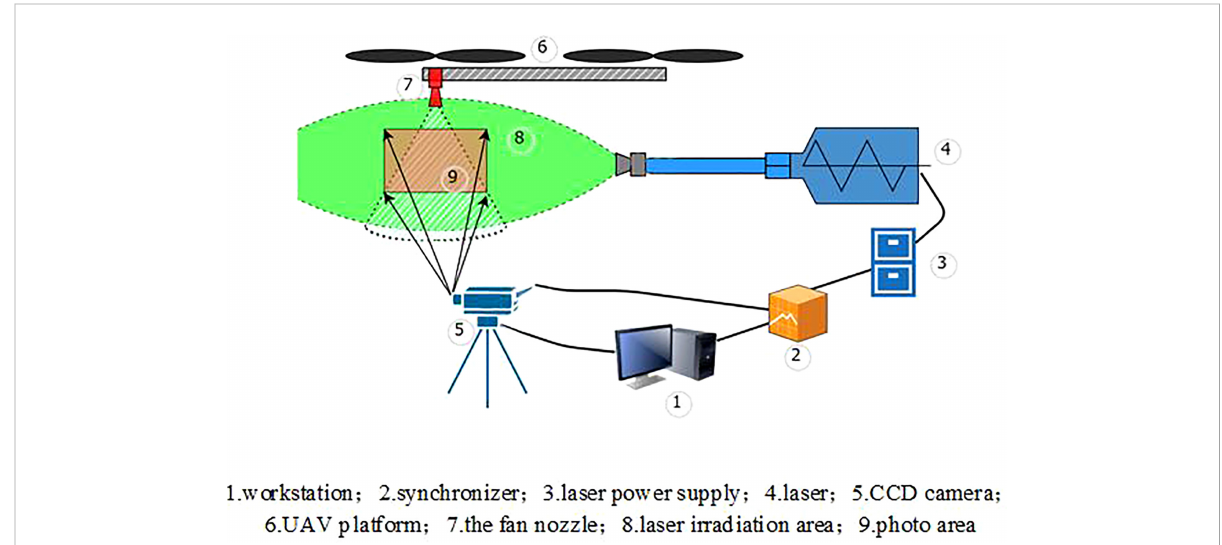
FIGURE 6 Schematic diagram of the